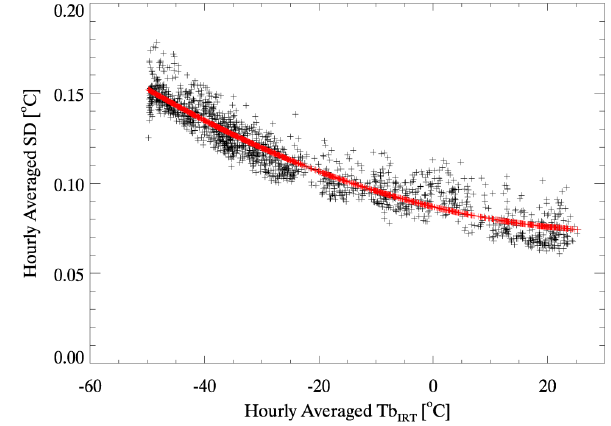
Figure 9. The relationship between the hourly averaged standard deviation and the hourly averaged Tb IRT . The red crosses are the relationship representing the best fit quadratic